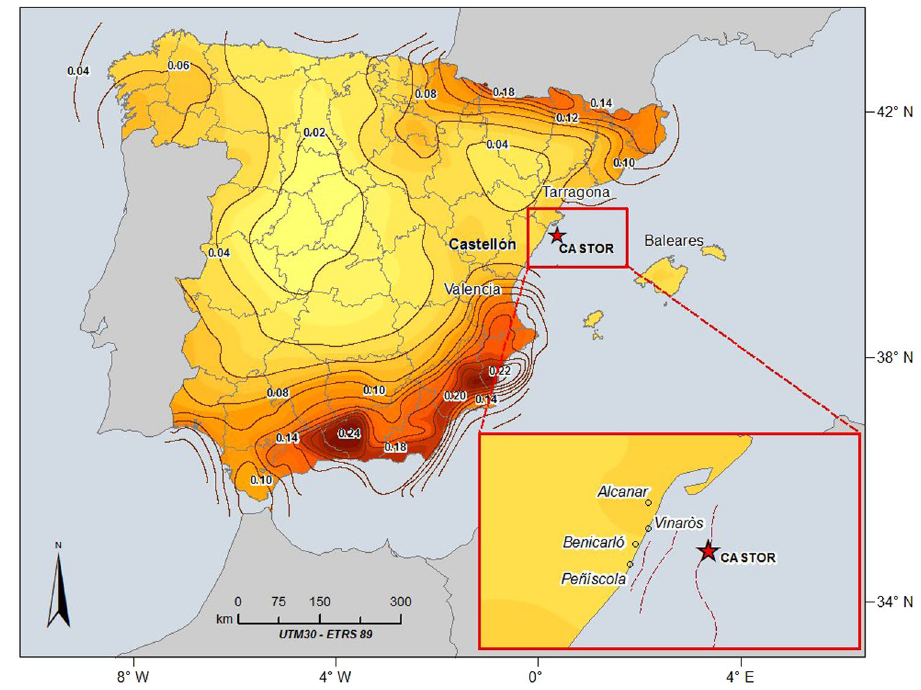
Figure 1. Castor platform location and the hazard map for return period of 475 years. The latter has been obtained in a recent study developed by the Polytechnic University of Madrid and the Spanish IGN aimed at the revision of the Spanish building code. The map shows the horizontal values of PGA on rock sites having 10% of probability of exceedance in 50 years (IGN-UPM, 2013 8 ). The figure was generated by using the ESRI software, ArcGIS for desktop, version